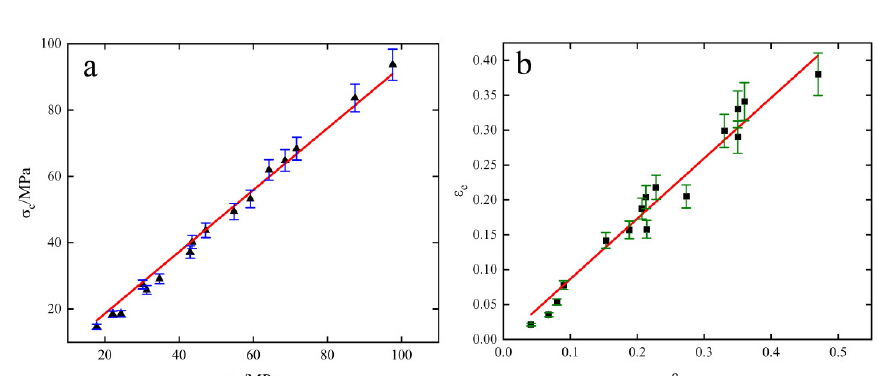
Figure 8. Critical condition fitting relationship. ( a ) − ; ( b ) −